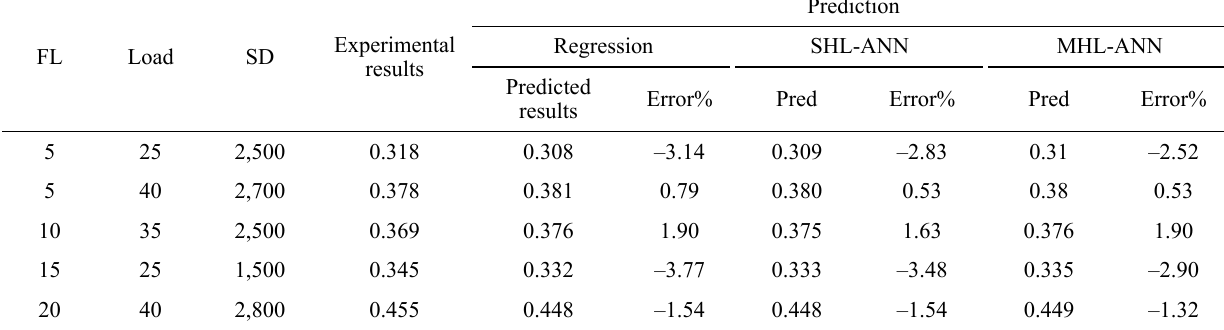
Table 23 Confirmatory tests for